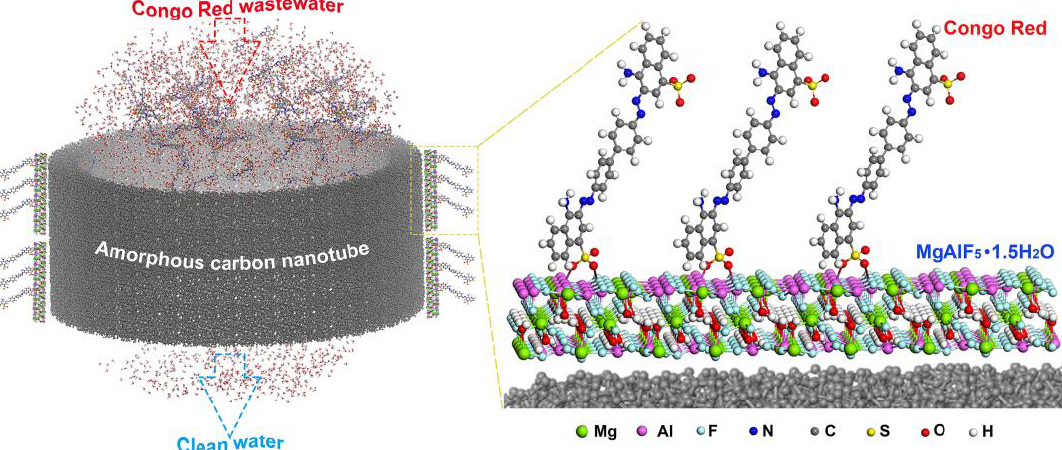
Figure 5. Proposed mechanism of dye adsorption over carbon-coated clay. Reprinted from ref. [87] with permission.